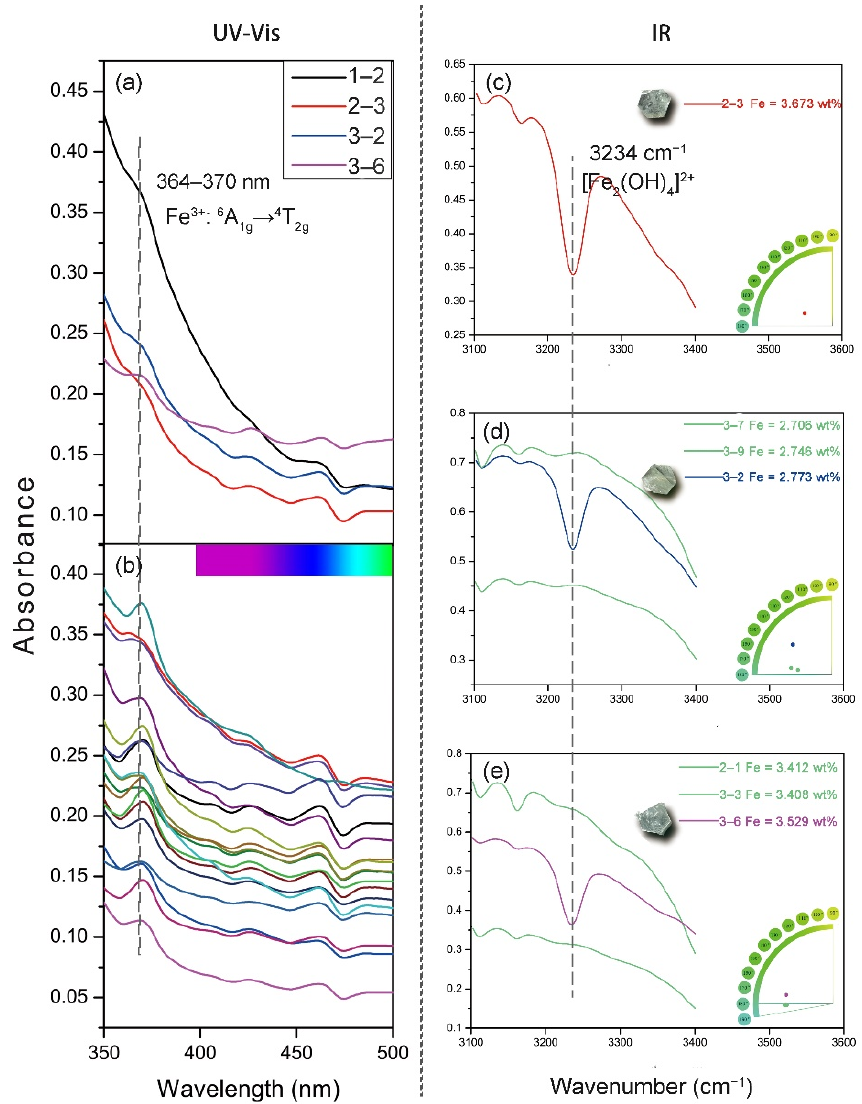
Figure 11. UV–vis and IR spectral characteristics of samples no. 2–3, 3–2, and 3–6. ( a ) The weak absorption peaks at 364–370 nm of sample no. 2–3, 3–2, 3–6, and reference sample no.1–2. ( b ) The strong absorption peaks at 364–370 nm of all samples except no. 2–3, 3–2, 3–6. ( c )The strong absorption peak at 3234 cm − 1 caused by [Fe 2 (OH) 4 ] 2+ of no. 2–3, and the Fe content of it is 3.673 wt %. ( d ) The strong absorption peak at 3234 cm − 1 caused by [Fe 2 (OH) 4 ] 2+ of no. 3–2, and the Fe content of it is 2.773 wt %. No.3–7 and 3–9 are lack of the peak caused by [Fe 2 (OH) 4 ] 2+ but have the similar Fe content with 3–2. ( e ) The strong absorption peak at 3234 cm − 1 caused by [Fe 2 (OH) 4 ] 2+ of no. 3–6, and the Fe content of it is 3.529 wt %. No. 2–1 and 3–3 are lack of the peak caused by [Fe 2 (OH) 4 ] 2+ but have the similar Fe content with 3–6. These characteristics suggest that when Fe ions are mainly present in the channels, they cause absorption in the near ultraviolet region and absorb the absorption peak at 364–370